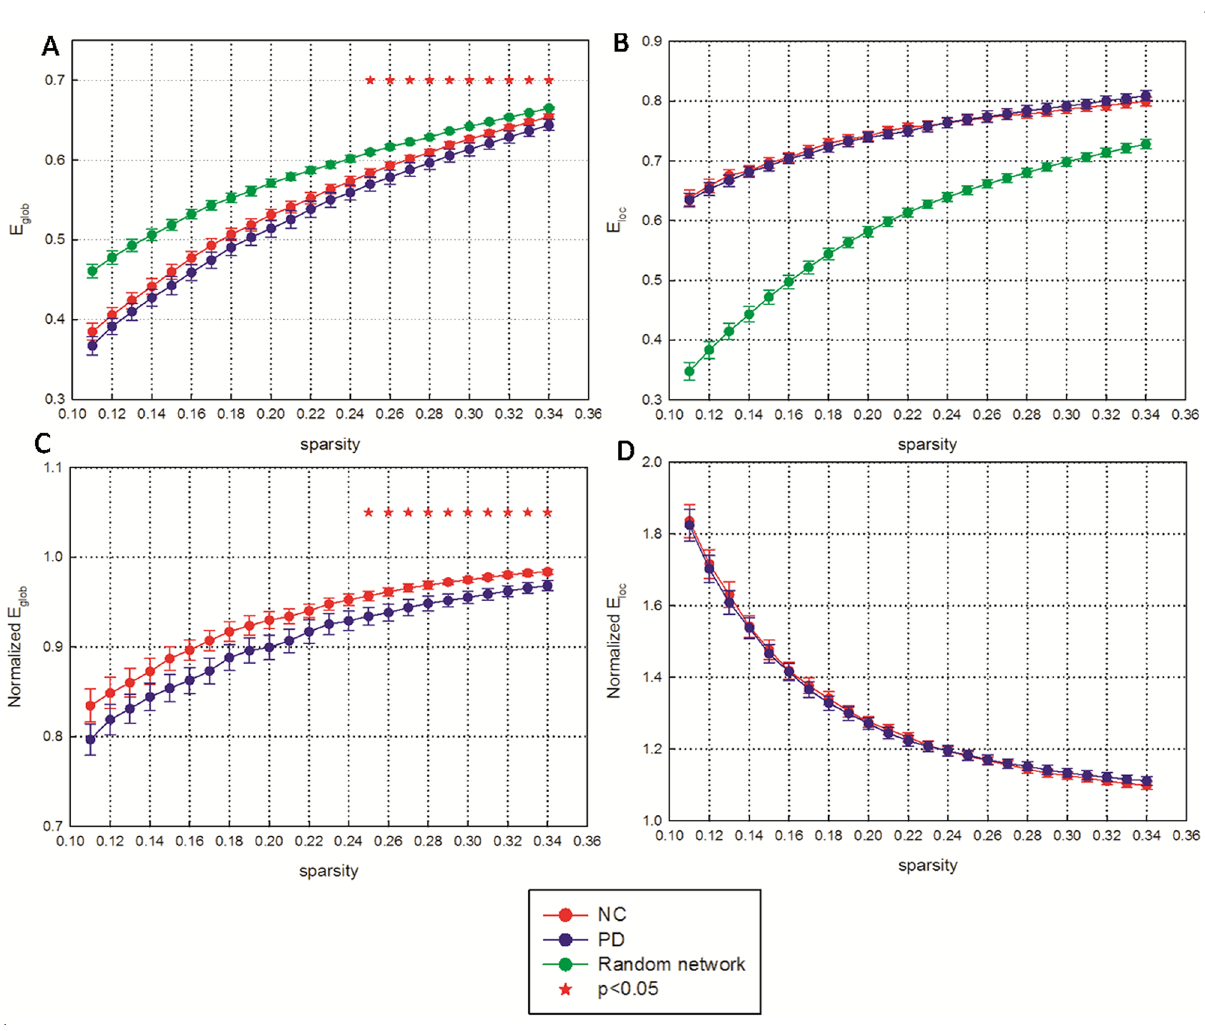
Fig 1. Network efficiency of functional brain networks as a function of sparsity among early-stage PD patients and normal controls. (A) Mean global efficiency and (B) mean local efficiency of the functional brain networks. (C) Normalized global efficiency and (D) normalized local efficiency of the functional brain networks. The functional brain networks showed increased local network efficiency but approximately identical global network efficiency of parallel information transmission compared with the matched random network. Error bars denote standard deviations. Red stars indicate statistically significant differences between the PD patients and the normal controls (p < 0.05). NC: normal controls; PD: Parkinson's disease.